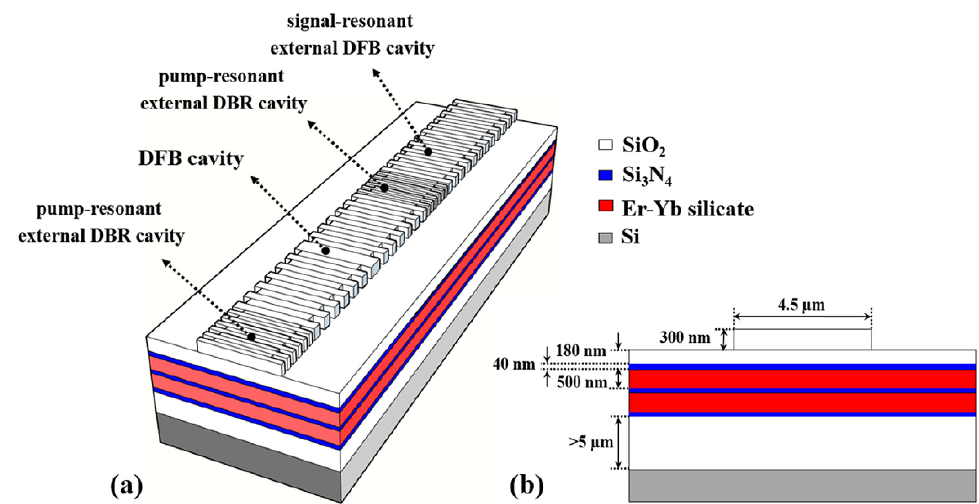
Figure 5. The 3D scheme diagram ( a ) and the cross section ( b ) of the silicon-based on-chip waveguide laser [63].